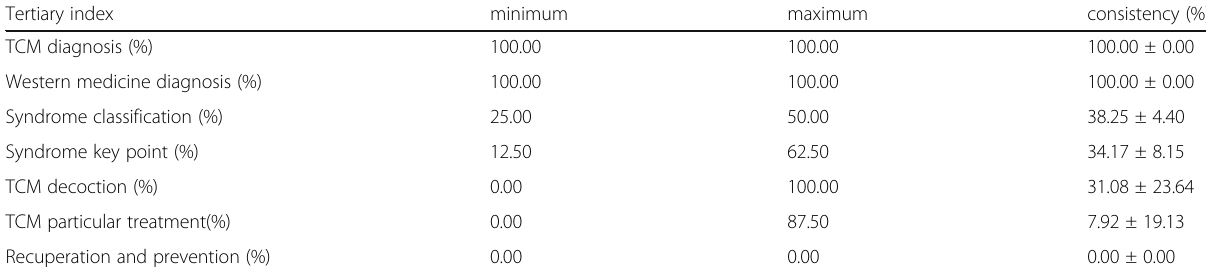
Table 5 Consistency of each tertiary index